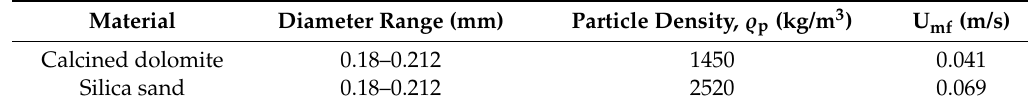
Table 1. Properties of particulate materials.